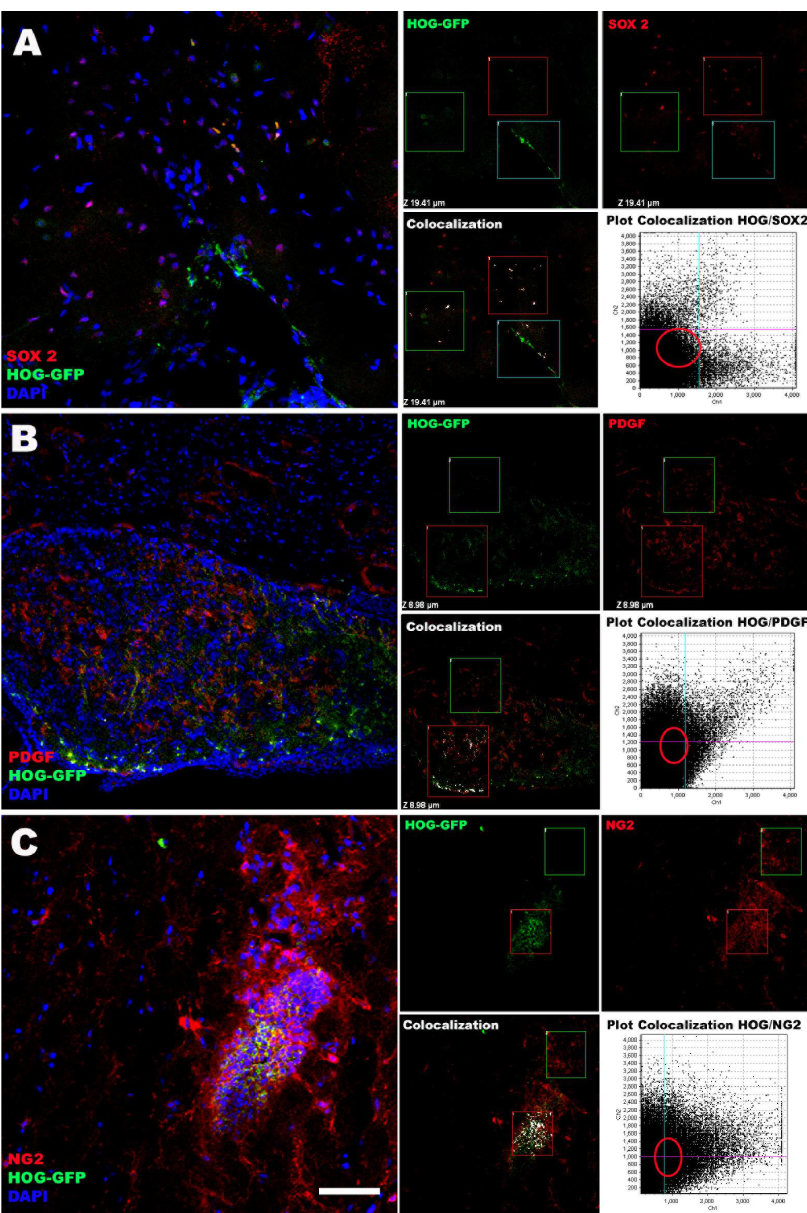
Figure 6. Confocal microscopy images showing immunofluorescence staining with OPC markers (SOX2 ( A ), PDGF ( B ), NG2 ( C )) in the septum and fimbria. GFP-labelled HOG cells are observed in the proximity of OPCs. Additionally, showing the Pearson colocolalization analysis, where regions of interest are observed that colocalize (threshold, white dotted) and other regions where cells that have positive labeling for OPCs are seen without being positive for the GFP label, these cells being endogenous OPCs (Only SOX2, PDGF or NG2). Scale bar: ( A , B ) (50 µ m) and ( C ) (25 µ